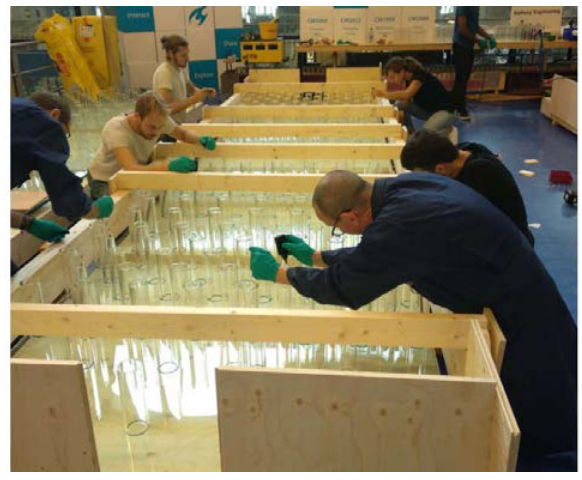
Fig. 11 applying adhesive to top of cylinder before placing top